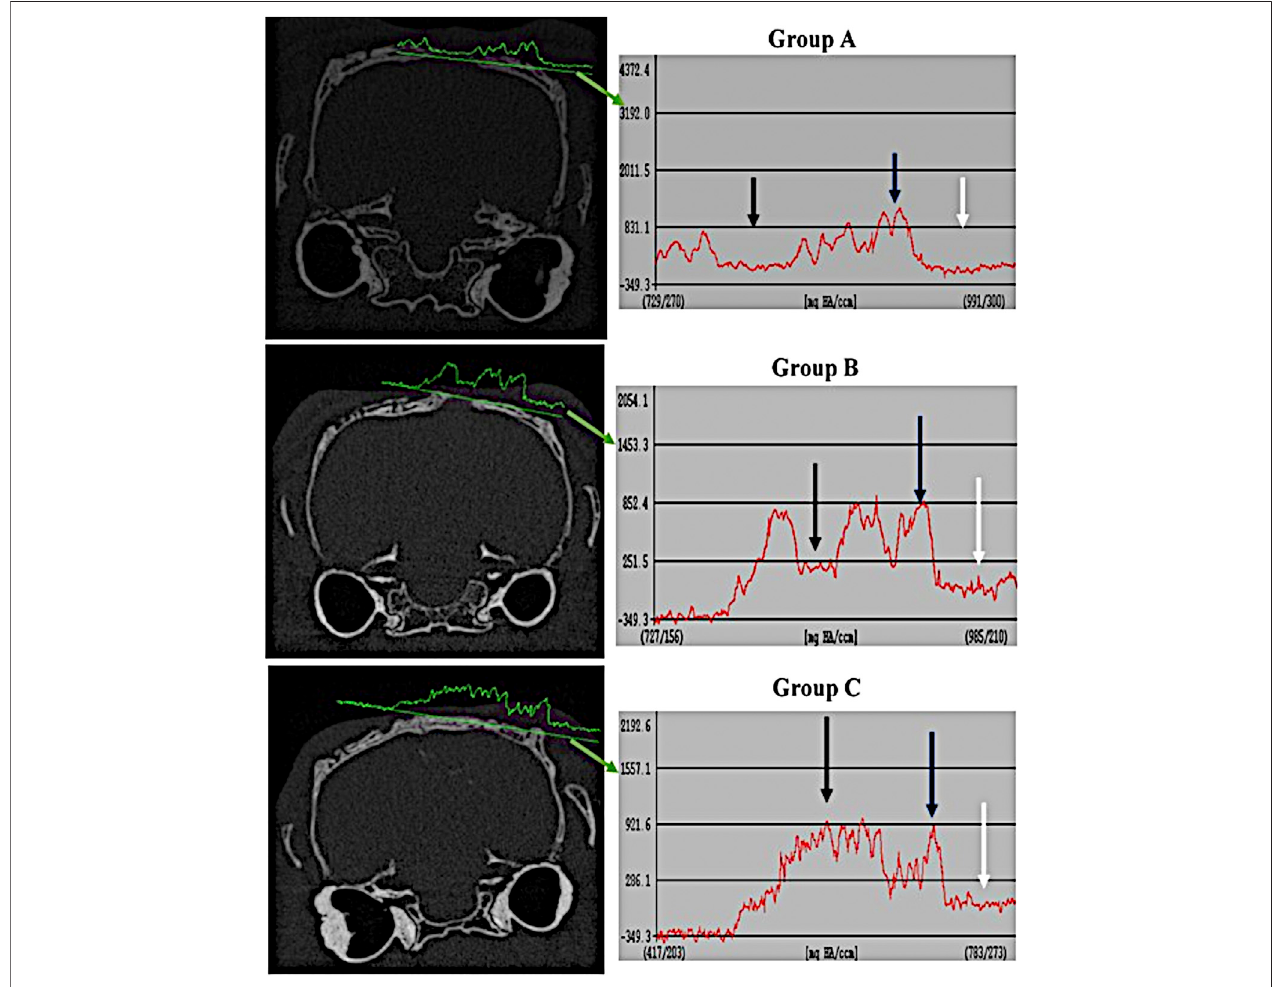
FIGURE4| Comparisonoftissuedensityofthehealingsurgicaldefectsbetweenthegroups(groupA(control),groupB(chitosangel),groupC(OPG-chitosangel)) at 12 weeks. Soft tissue at the periphery (white arrows); Normal bone (blue arrows); Center of defect (black arrows).